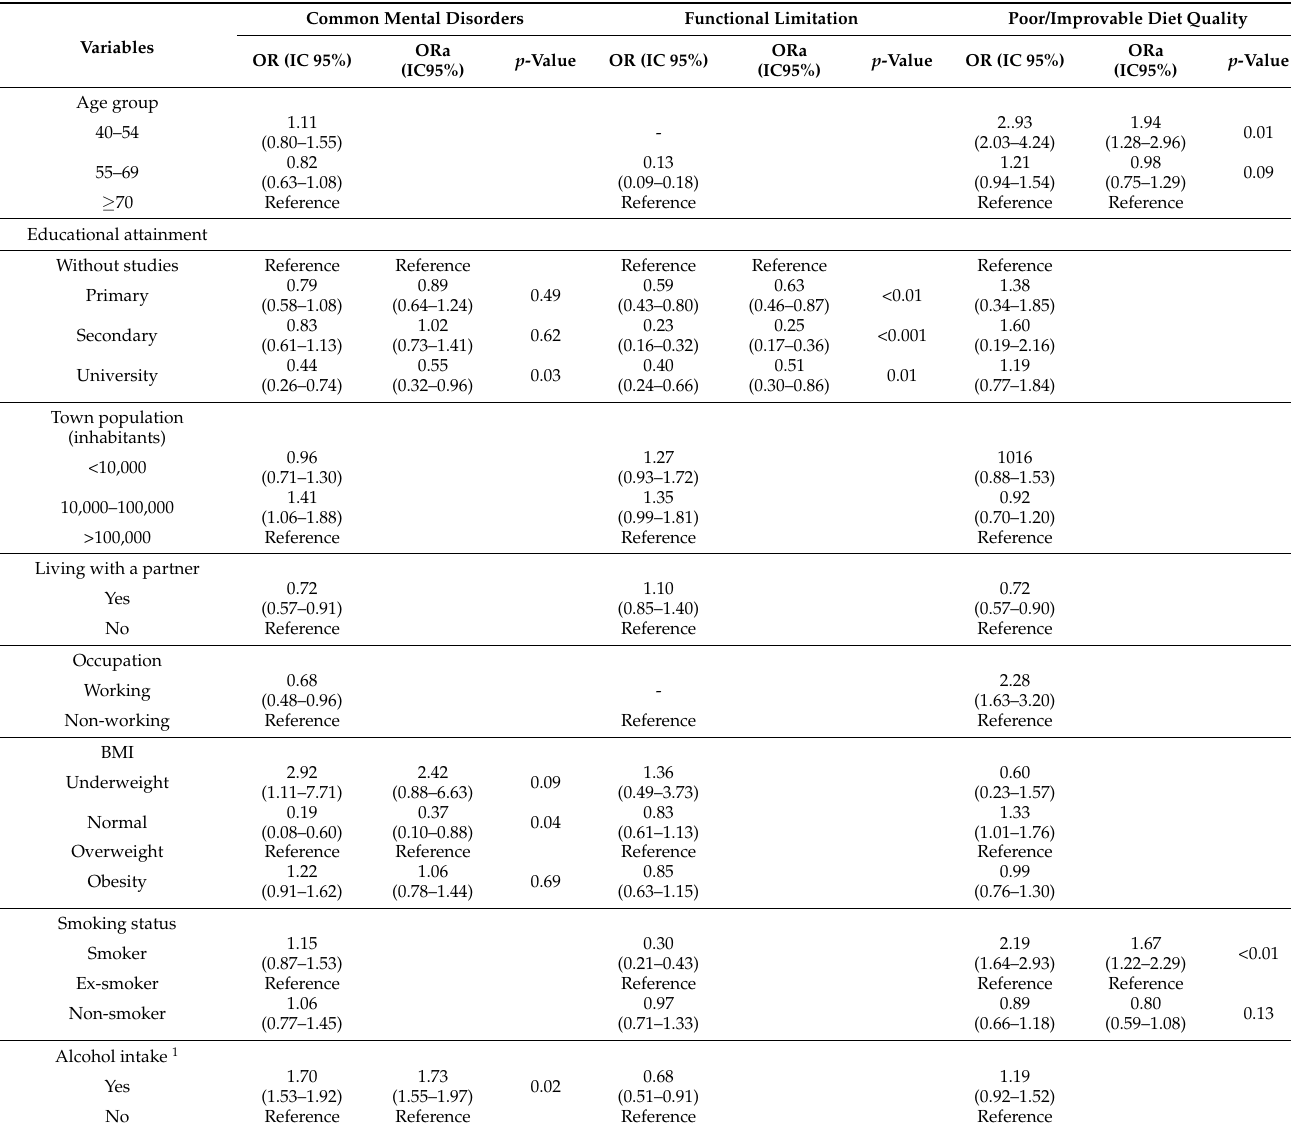
Table 4. Association between CMDs, functional limitation and poor/improvable diet quality, and sociodemographic factors, health-related determinants and use of clinical preventive care services in men with COPD ( n = 1277).